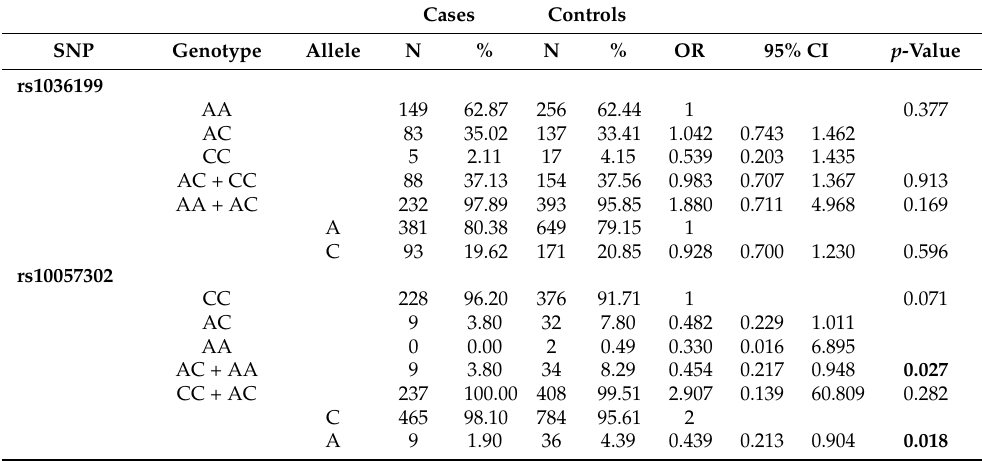
Table 1. Genotype and allele distribution of TIM-3 and LGALS9 SNPs among ccRCC patients and